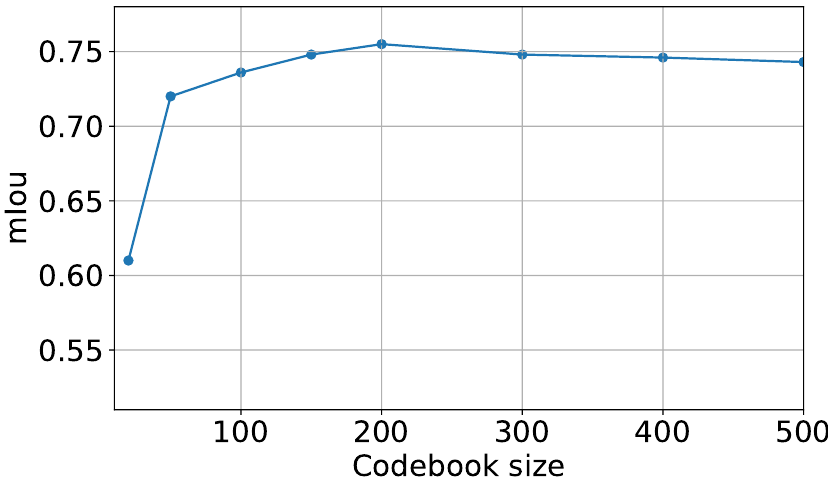
Figure 6. Performance with different codebook size.